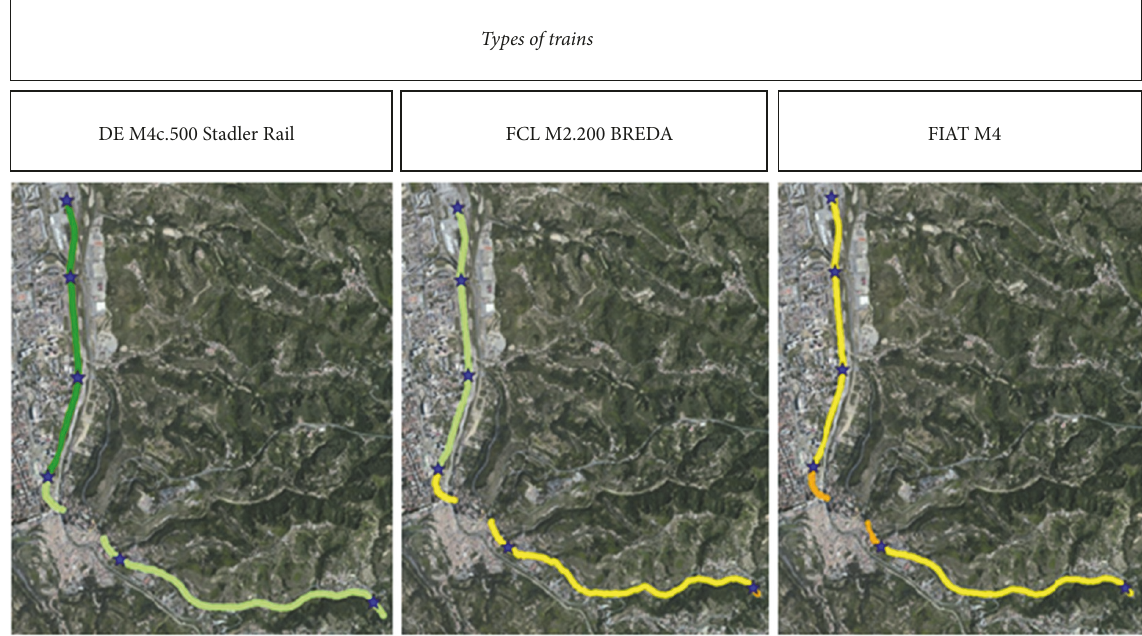
Figure 13: Excerpt of the CI (rail) trend on the route Cosenza Vaglio Lise-Bosco.